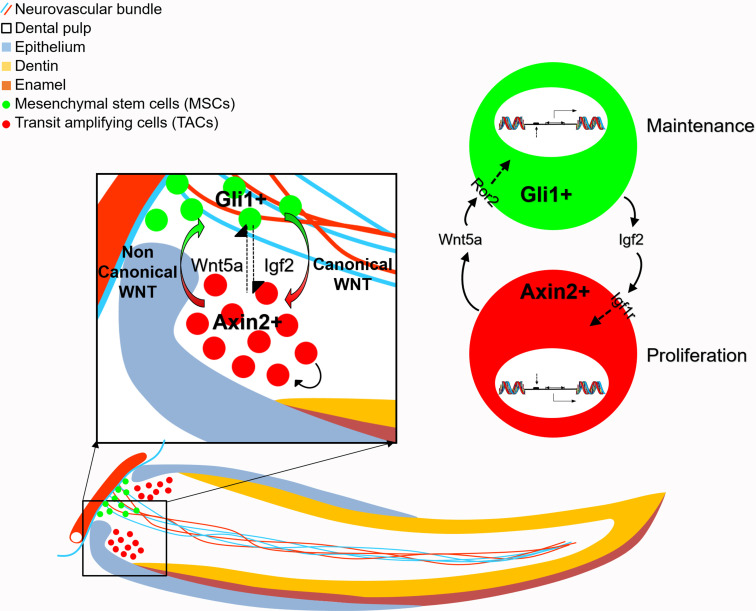
Schematic diagram of bidirectional interaction between transit amplifying cells (TACs) and mesenchymal stem cells (MSCs).Igf2 secreted from Gli1+ MSCs binds to Igf1r in the Axin2+ TACs, activating target gene expression and regulate TAC proliferation. Wnt5a serves as a non-canonical WNT ligand, feeding back to MSCs through Ror2 to activate downstream gene expression to regulate the maintenance of MSCs. Thus, MSCs and TACs dynamically interact with each other to maintain mesenchymal tissue homeostasis.